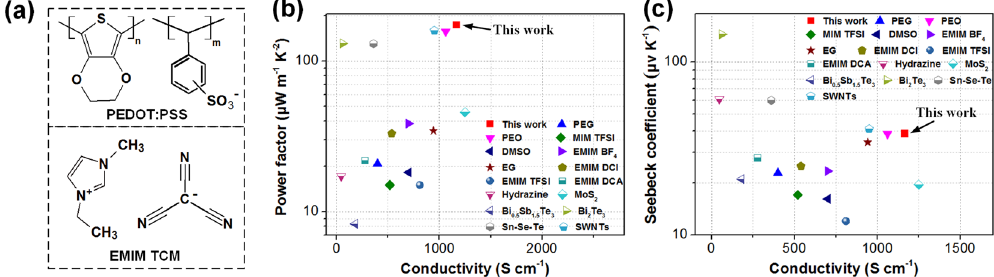
Fig. 1 Chemical structures and TE performance of PEDOT:PSS. a Chemical structures of PEDOT:PSS and EMIM:TCM. b , c Comparison of the as-prepared PEDOT:PSS hybrid in this work with the reported post-treatment-free PEDOT:PSS at power factor ( b ) and Seebeck coef fi cient ( c